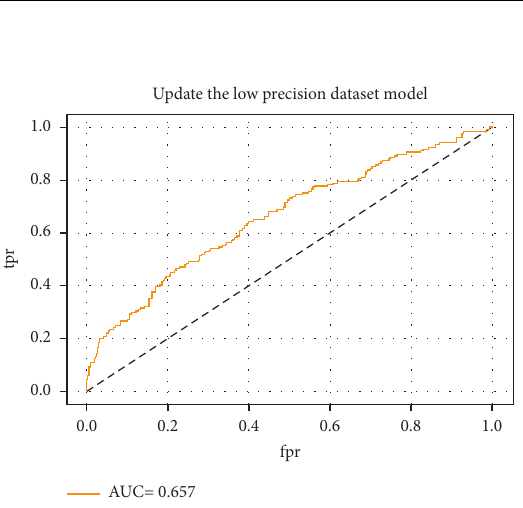
Figure 11: ROC curve and AUC value of the updated high pre- cision data set model. Table 11: The results of the updated low precision data set model.